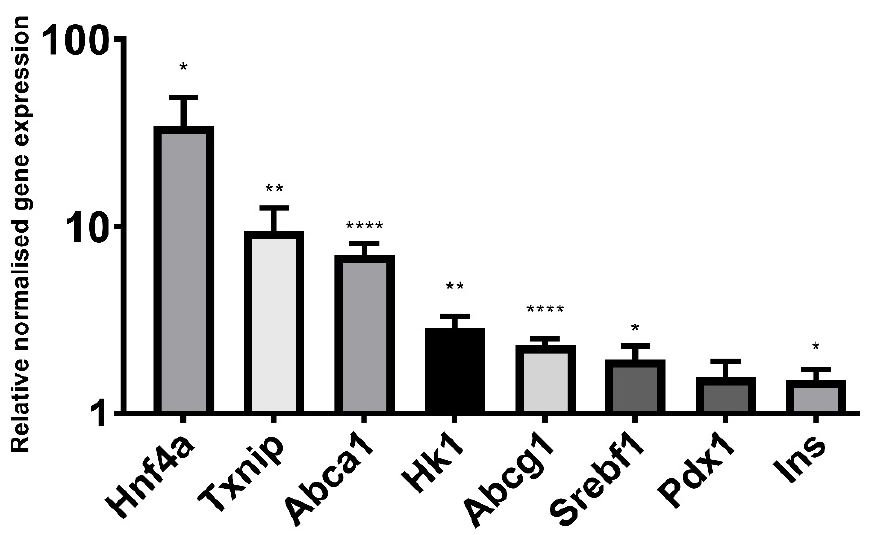
Figure 7. qPCR of glucose metabolism genes. Relative gene expression in BRIN-BD11 cells treated with 5 mM sodium butyrate compared to the untreated control (value of 1). Gene expression is normalised to reference genes Actb and Rpl13a. Results represent the mean combined from three independent experiments, with error bars representing SEMs. * p < 0.05, ** p < 0.01, **** p < 0.0001.